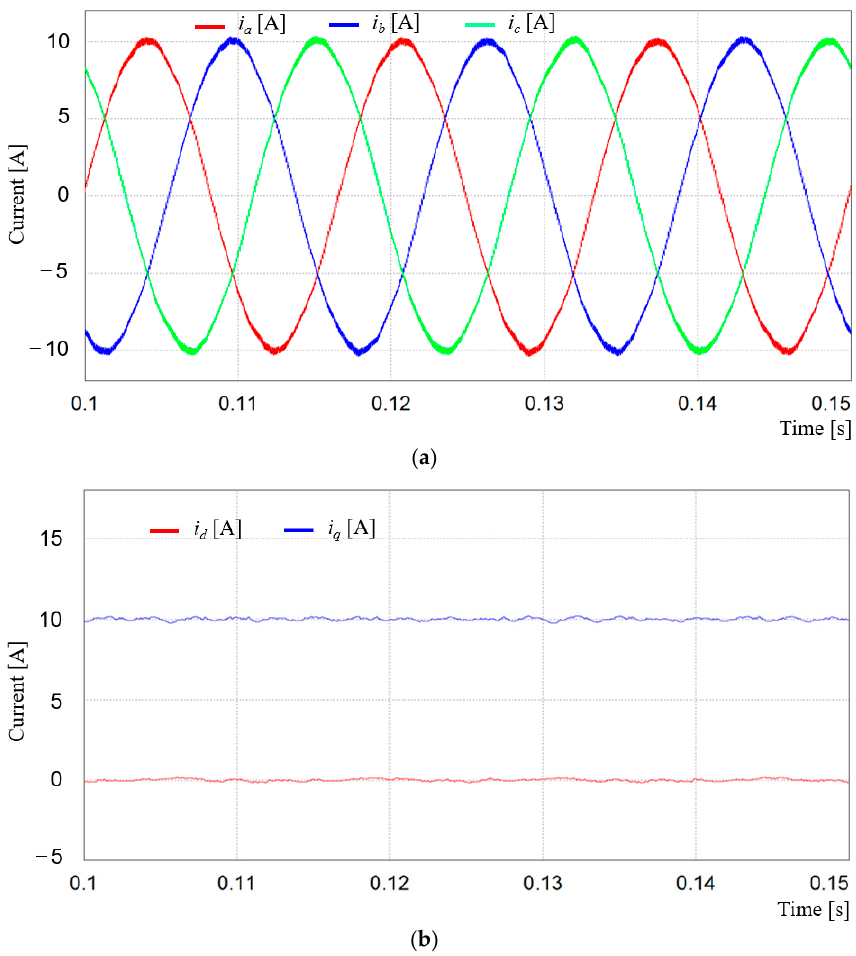
Figure 4. Inverter currents of the conventional PI decoupling controller under the ideal grid voltages. ( a ) Phase currents; ( b ) q- axis and d- axis currents.